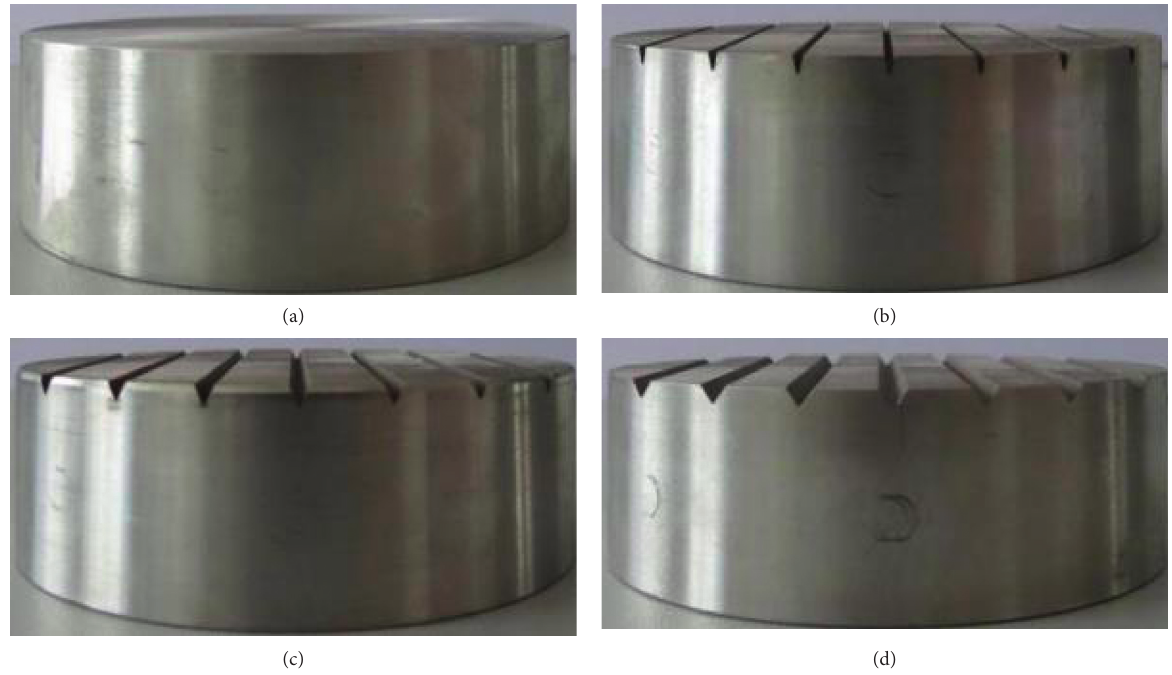
Figure 6: Elevation of the steel plate used in the test. (a) Int-A; (b) Int-B; (c) Int-C; (d)